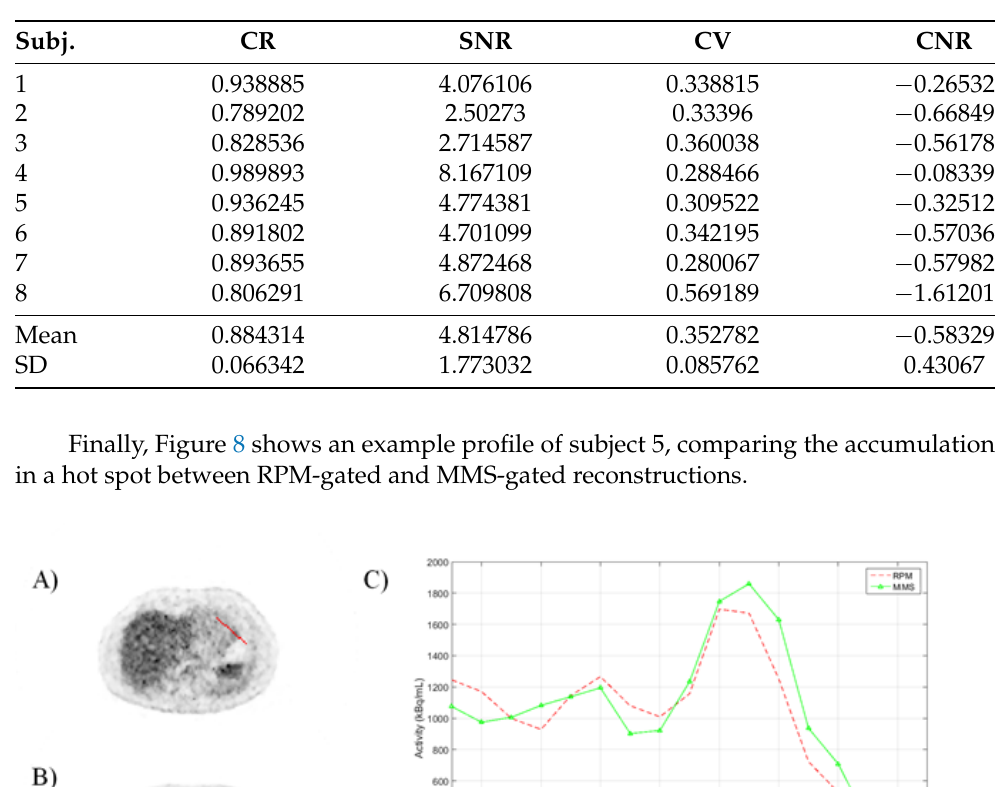
Table 9. Image quality metrics corresponding to RPM-based respiratory-gated reconstructions. CR = contrast ratio, SNR = signal to noise ratio, CV = coefficient of variation, CNR = contrast to noise ratio.